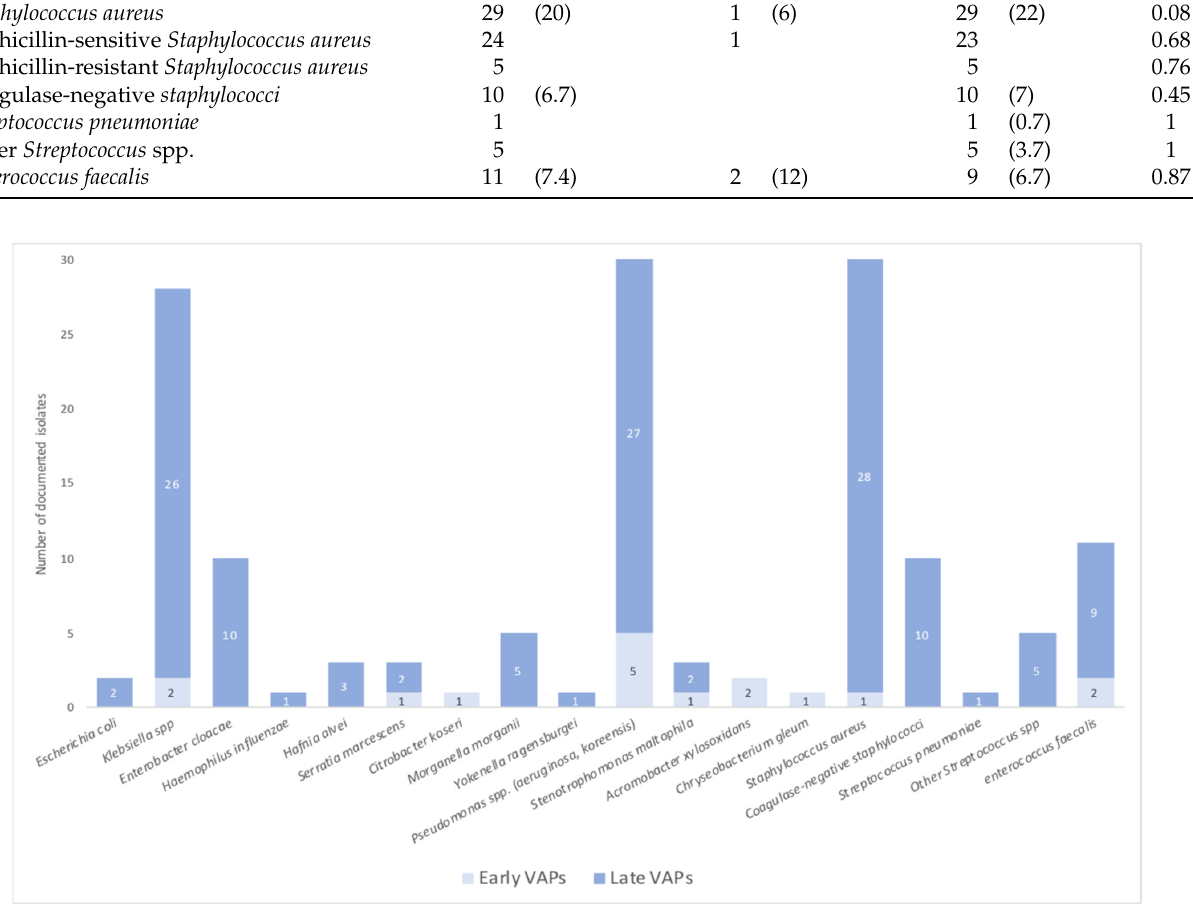
Figure 2. Ventilation-acquired pneumonia bacterial documentation .